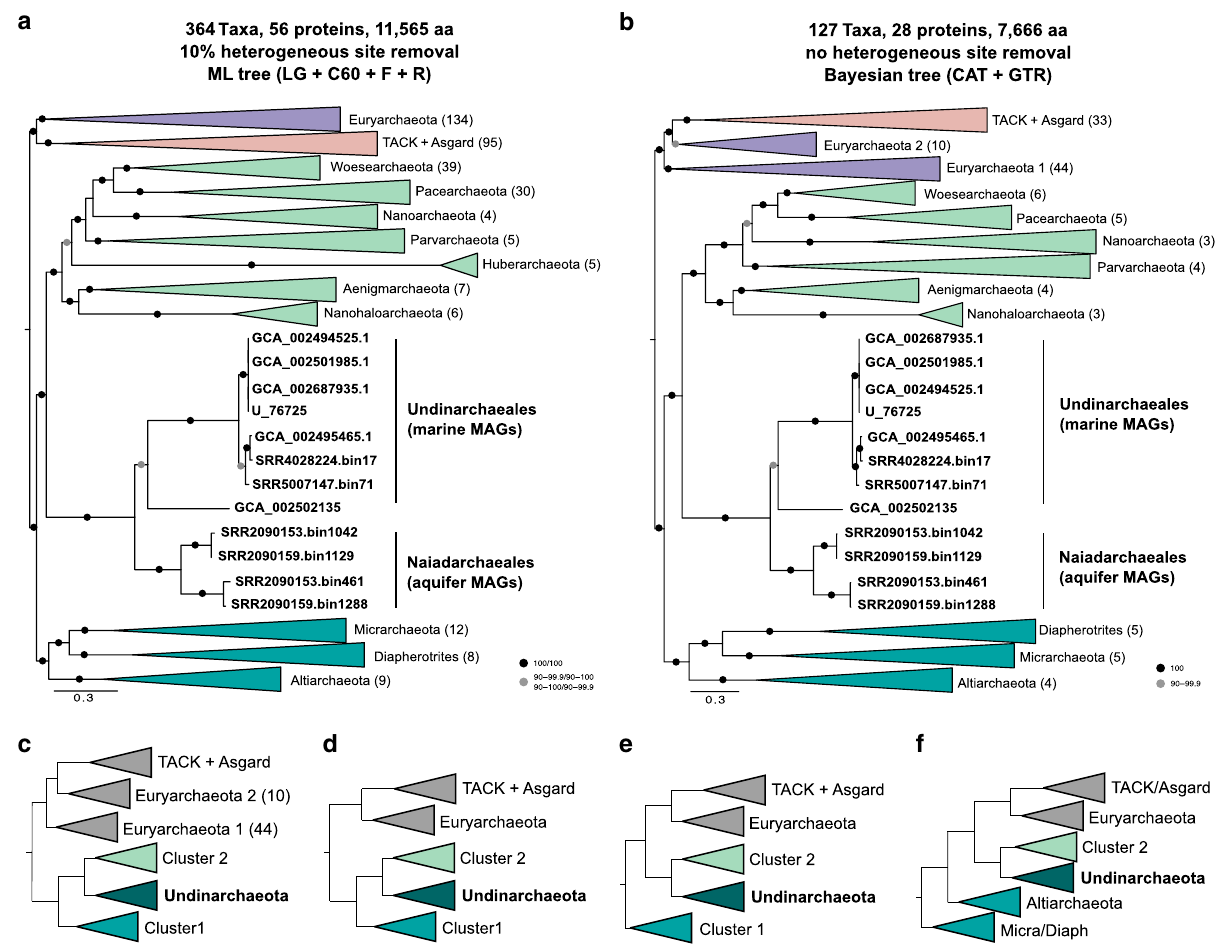
Fig. 1 Phylogenetic placement of Undinarchaeota. a Maximum-likelihood phylogenetic analysis (LG + C60 + F + R model) of the concatenated 50% top- ranked marker proteins ( n = 56) and 364 taxa set. For this alignment 10% of the most heterogeneous sites were removed using chi2 pruning. The full tree is shown in Supplementary Fig. 19. b Bayesian phylogenetic tree (CAT + GTR model) of an alignment generated with the 25% top-ranked marker proteins ( n = 28) and 127 taxa set. The full tree is shown in Supplementary Fig. 10. Euryarchaeota 1 includes all Euryarchaeota with the exception of Theionarchaea, Thermococci, Persephonarchaea and Hadesarchaea, which are clustered in Euryarchaeota 2. Scale bar: Average number of substitutions per site. c – f Possible positions of the archaeal root inferred using bacteria as an outgroup ( c ) or using the nonreversible model in IQ-TREE 2 d – f . All of these methods recover a clade of Undinarchaeota and Cluster 2 DPANN, consistent with synapomorphies including a fused DNA primase and a reduced exosome that lacks